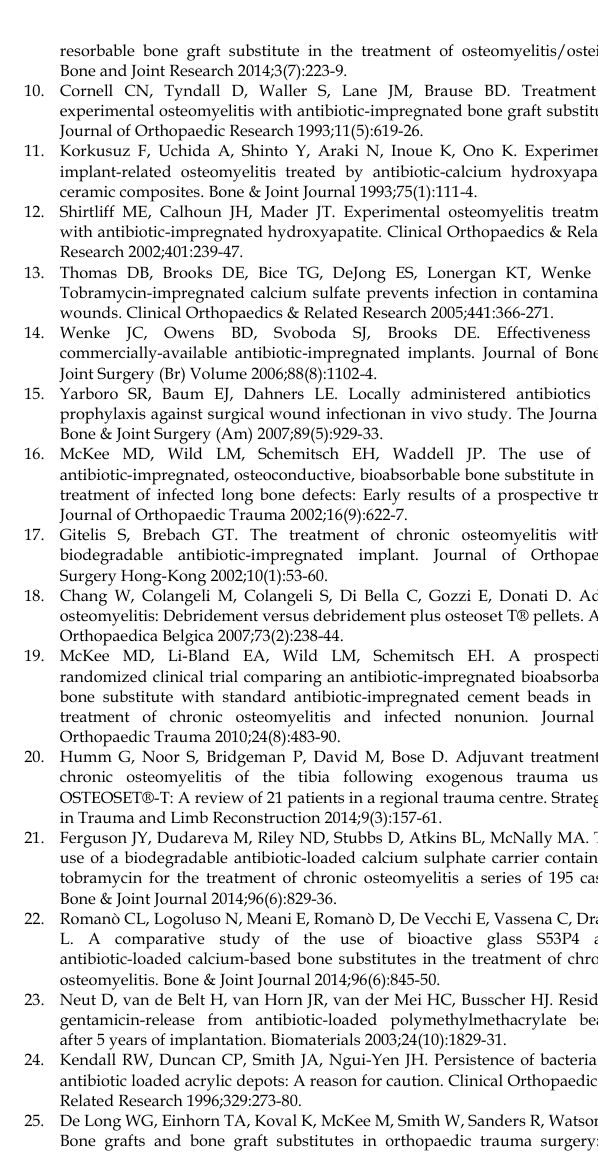
Figure 6. (A) This infected non-union of the proximal humerus occurred after attempted minimal internal fixation with Kirschner wires. The non-union has been excised and internally fixed in a single procedure. (B) The small bone defects around the non-union, the empty holes in the plate and the central medullary space have been filled with calcium sulphate/hydroxyapatite biocomposite with gentamicin